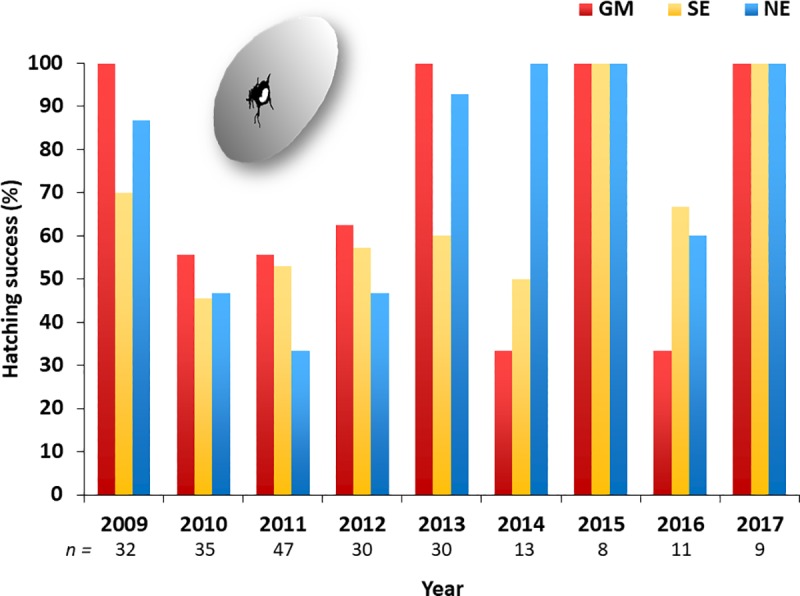
Multi-year hatching success (%; number of chicks hatched/eggs laid) of three migrant groups of Northern Gannets nesting on Bonaventure Island, Canada, and wintering in the Gulf of Mexico (GM), southeast coast of the U.S. (SE) and northeast coast of the U.S. (NE) from 2009 to 2017.There is no interaction between migrant groups and hatching success (P > 0.05) but an interaction between year and hatching success (P < 0.0001). Bottom line n represent the total of nests for all categories. We used only the data for instrumented birds in 2010–2011 and 2011–2012, and for which we monitored hatching success between 2009 and 2017. Given the very high fidelity to wintering sites in gannets [25], we assume that individuals keep the same area year after year.